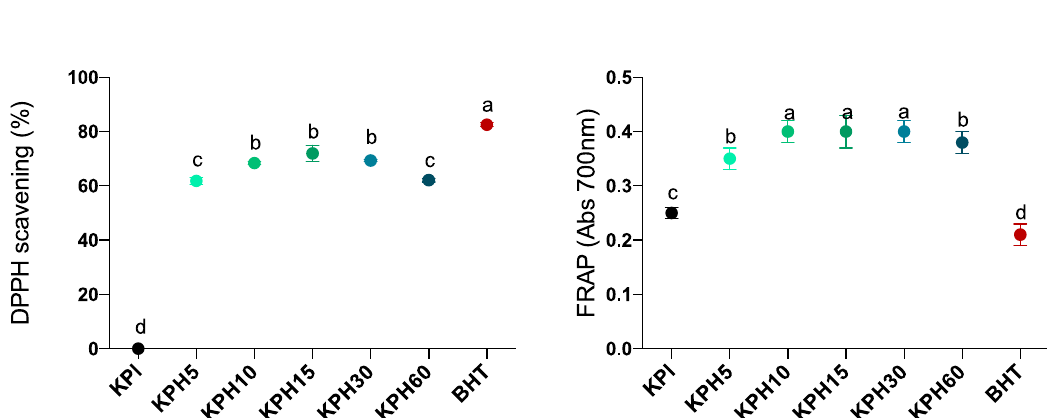
Figure 3. ( a ) DPPH free radical scavenging activity and ( b ) FRAP (ferric reducing antioxidant power) of KPI and KPHs obtained with Bioprotease in an in vitro cell-free experiments. Values are represented as means ± standard deviation of three determinations. Statistical differences are marked with different letters ( p < 0.05).